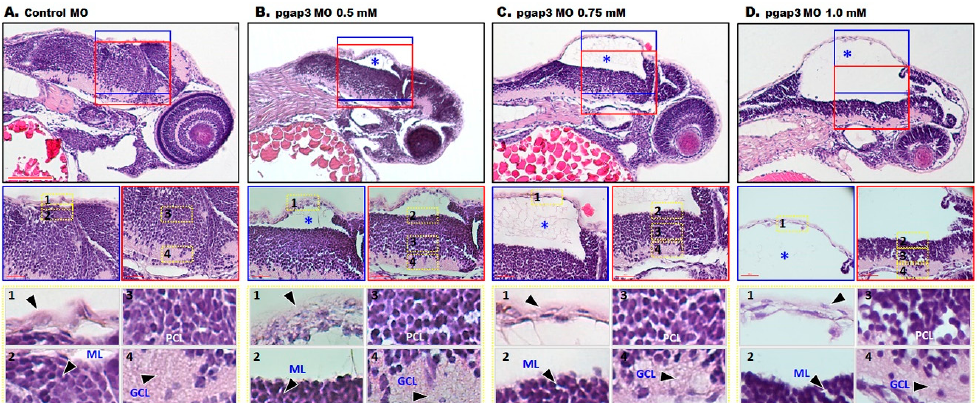
Figure 6. Histopathology of zebrafish Pgap3 knockdown model. Images of Hematoxylin and Eosin stained brain tissue sagittal sections from zebrafish larvae at 72 h post-fertilization (hpf). ( A ) Zebrafish injected with control MO displayed normal brain development, normal brain epithelium with an expanded molecular layer (ML), Purkinje cell layer (PCL), and granule cell layer (GCL). Subsets